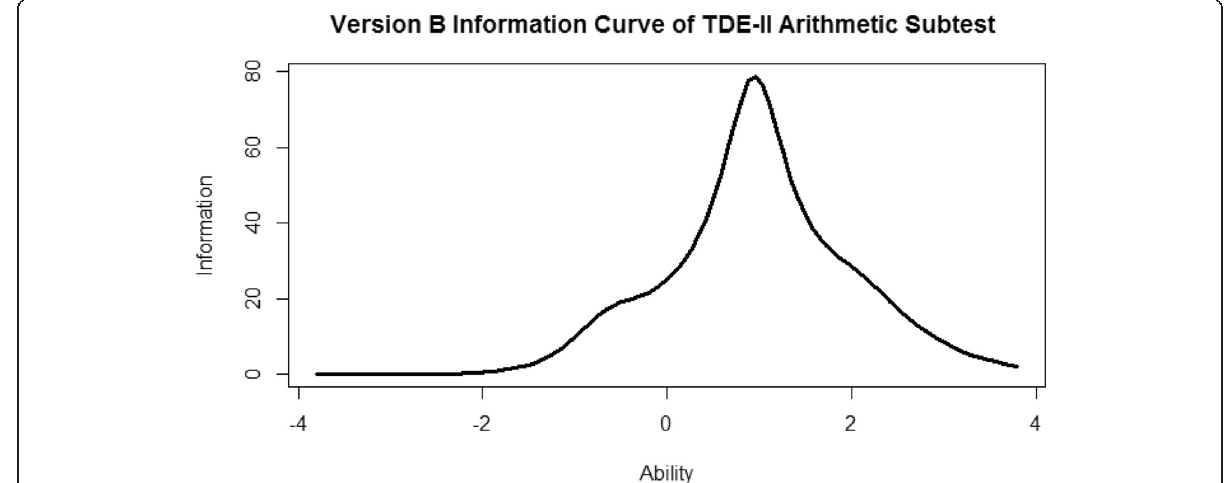
Fig. 2 Version B test information curve of the TDE-II Arithmetic